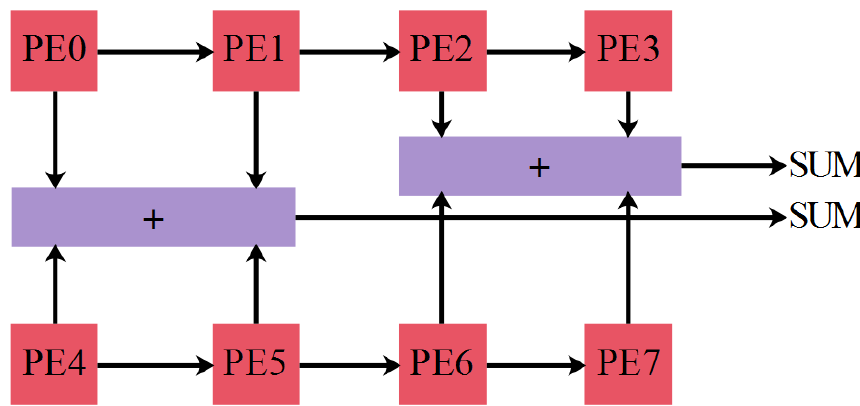
Figure 3. Convolutional operation of 5 × 5.